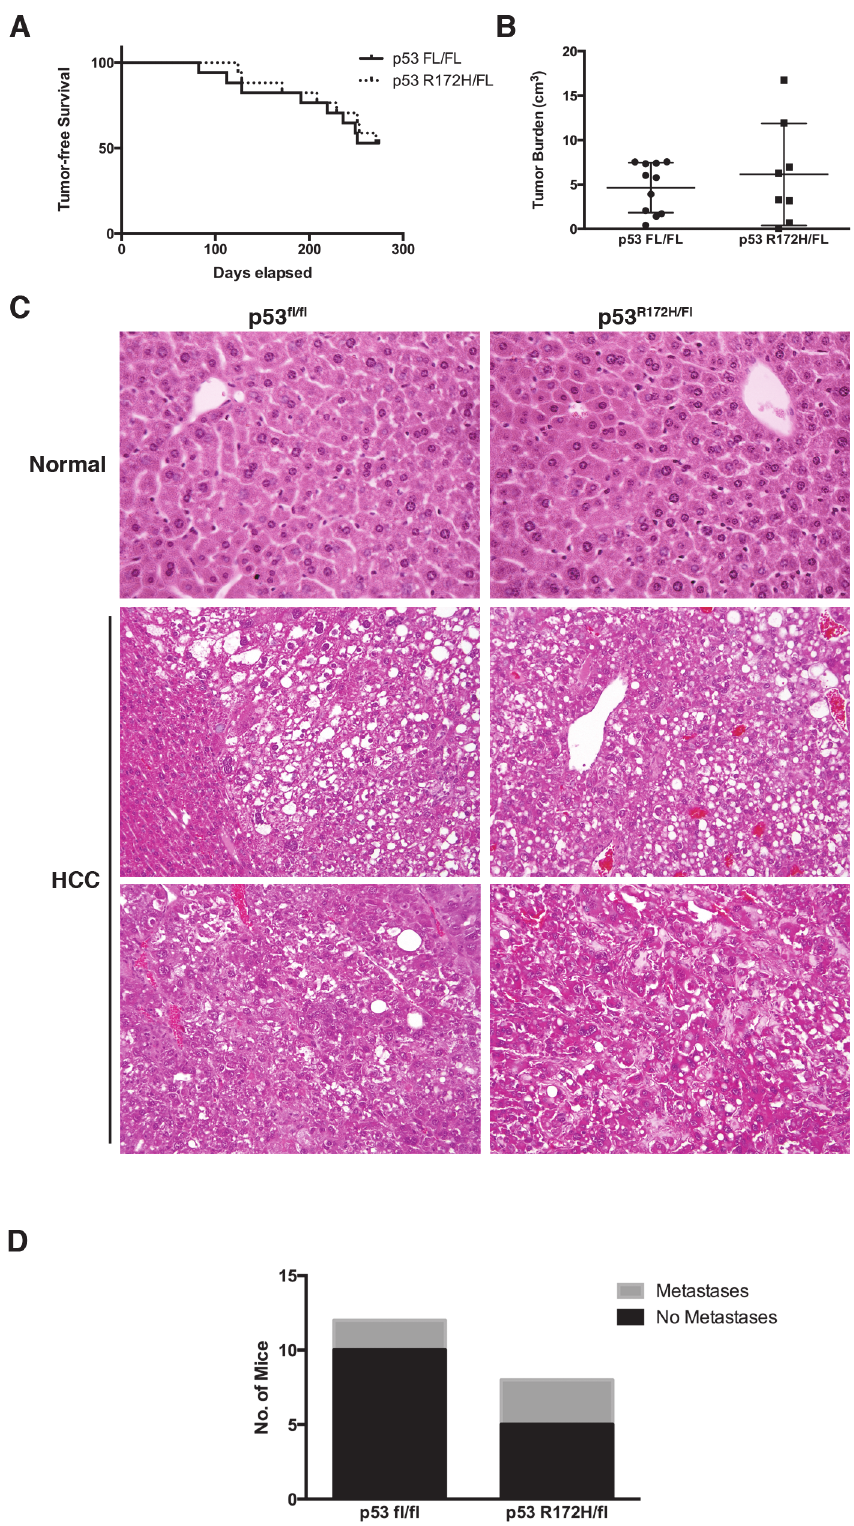
Fig 1. p53 R172H does not result in gain-of-function properties in an HCC mouse model. A) Kaplan-Meier curve displaying tumor free survival of p53 fl/fl and p53 R172H littermates. Mice were assessed over a period of 9